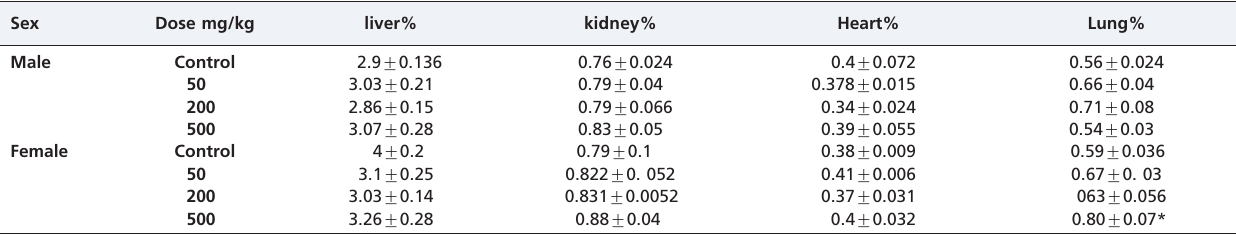
Table 3 - Relative organ weight at termination of treatment with E. platyloba (g % body weight). Sex Dose